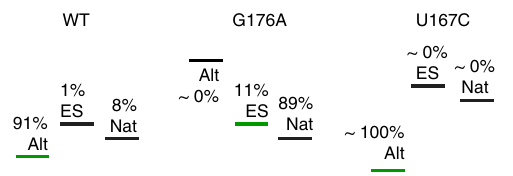
Figure 5 | Free-energy diagrams of tP5abc (left), tP5abc G176A (middle) and tP5abc U167C (right) in the presence of 1mM Mg 2 þ at 10 (cid:2) C. Energy bars coloured in green indicate that they are also the GSs in the absence of Mg 2 þ . All states are labelled with their associated